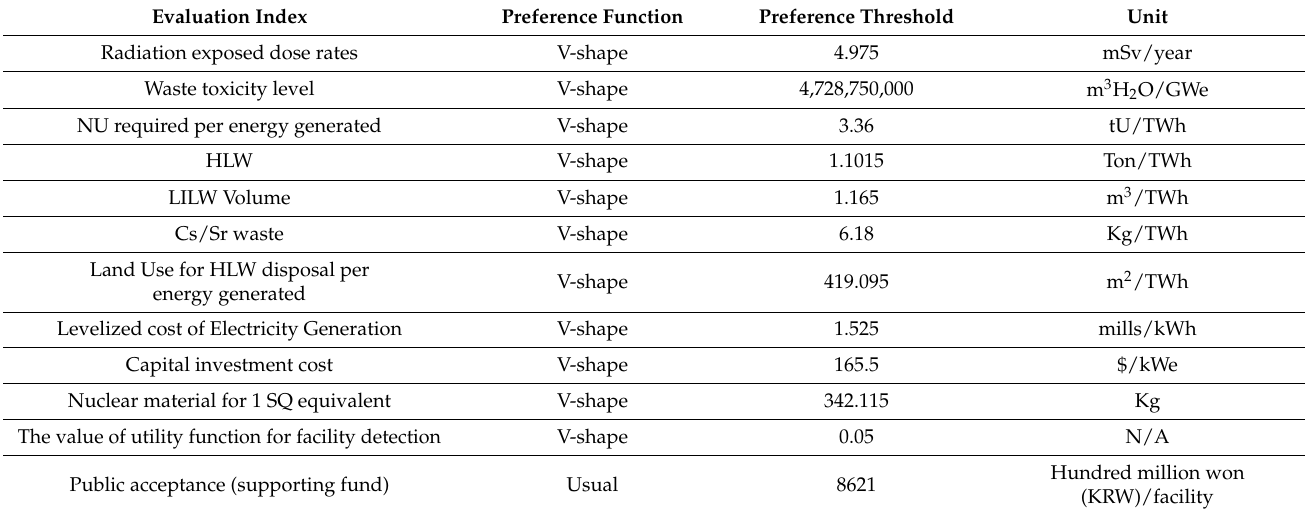
Table 11. Preference function and preference threshold.